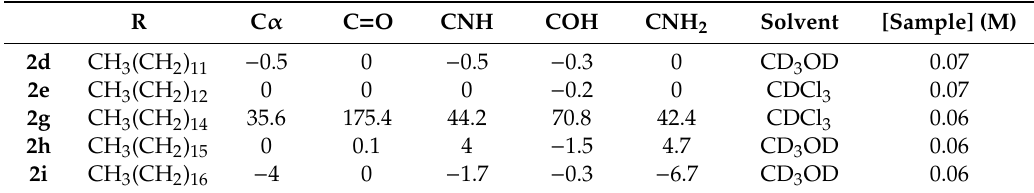
Table 3. ∆ ppm taken with respect to the 13 C chemical shifts of 2g of the four carbons bound to atoms able to participate in H-bonds and the α -carbon of the acyl chain.